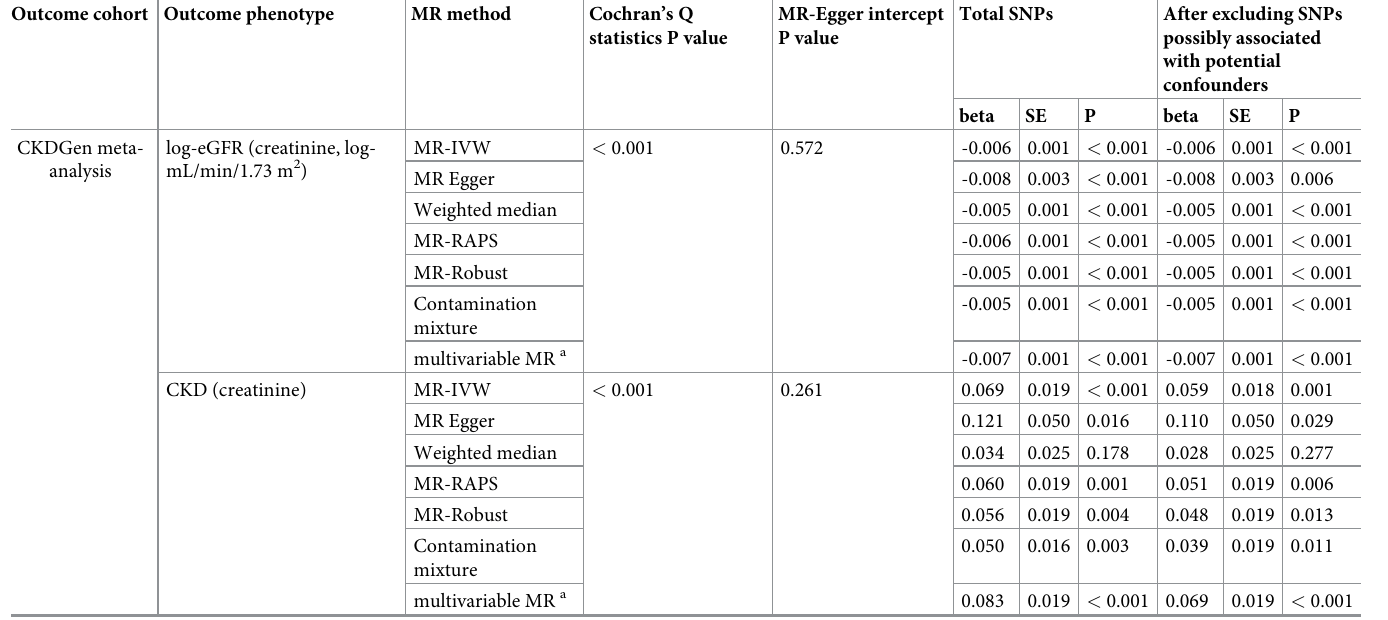
Table 3. Summary-level MR results showing causal estimates of taller height on estimated kidney function